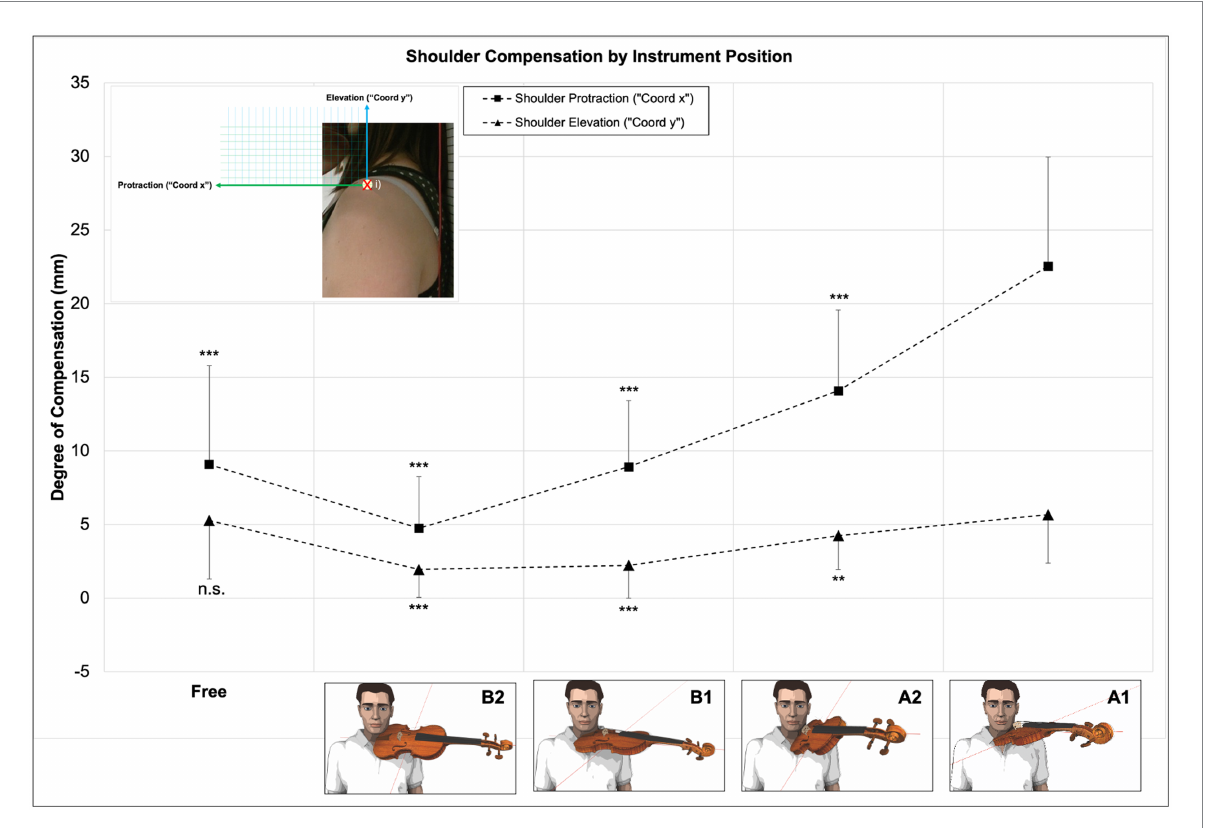
FIGURE 10 Degree of shoulder compensation movement expressed as “Coord x” and “Coord y” by instrument position. Differences between violin position A1 and all other instrument positions under test highly significant ( p < 0.001), except for A2 in “Coord y” ( p < 0.01) and Free in “Coord y”